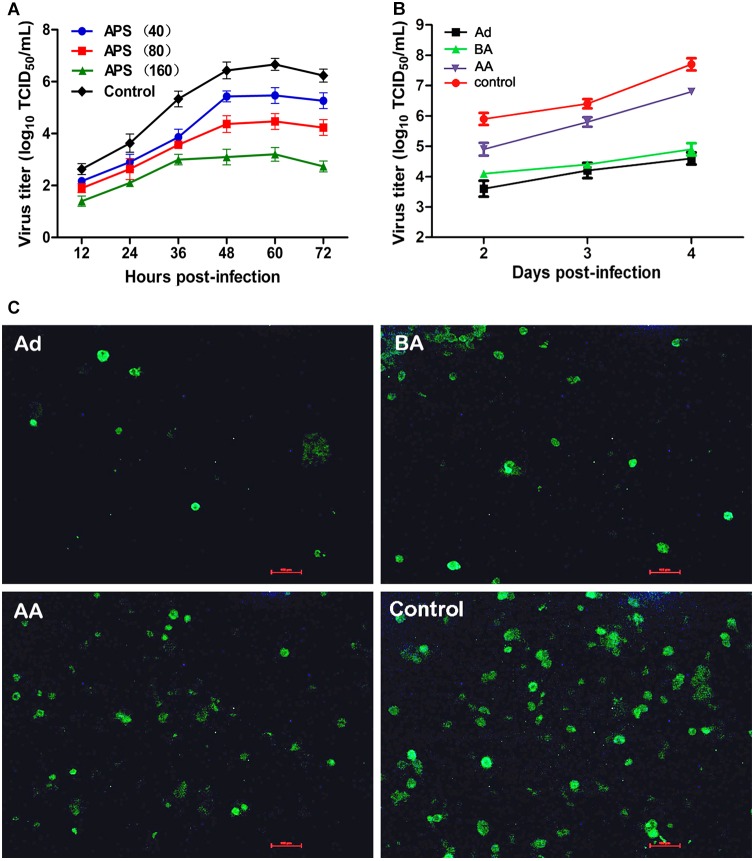
Aloe polysaccharides (APS) inhibits influenza virus replication in MDCK cells. (A) The MDCK cells were cultured with medium containing different concentrations of APS and then infected with PR8 virus [(MOI) = 1]. The virus titers of the culture supernatant collected each 12 h were determined by TCID50. The number in parentheses represent the concentration of drug; (B) MDCK cells infected with PR8 virus [(MOI) = 1] were treated with 40 μg/mL of APS at different viral infection phases [before adsorption (BA), adsorption (Ad), and after adsorption (AA)] in the whole infection process. Supernatants were collected at each 24 h interval and titrated by TCID50. (C) IFA detection of PR8 virus infected cells treated with APS at 4 days after inoculation. PBS treated cell wells served as the control. All values shown are presented as means ± SD from three independent experiments.